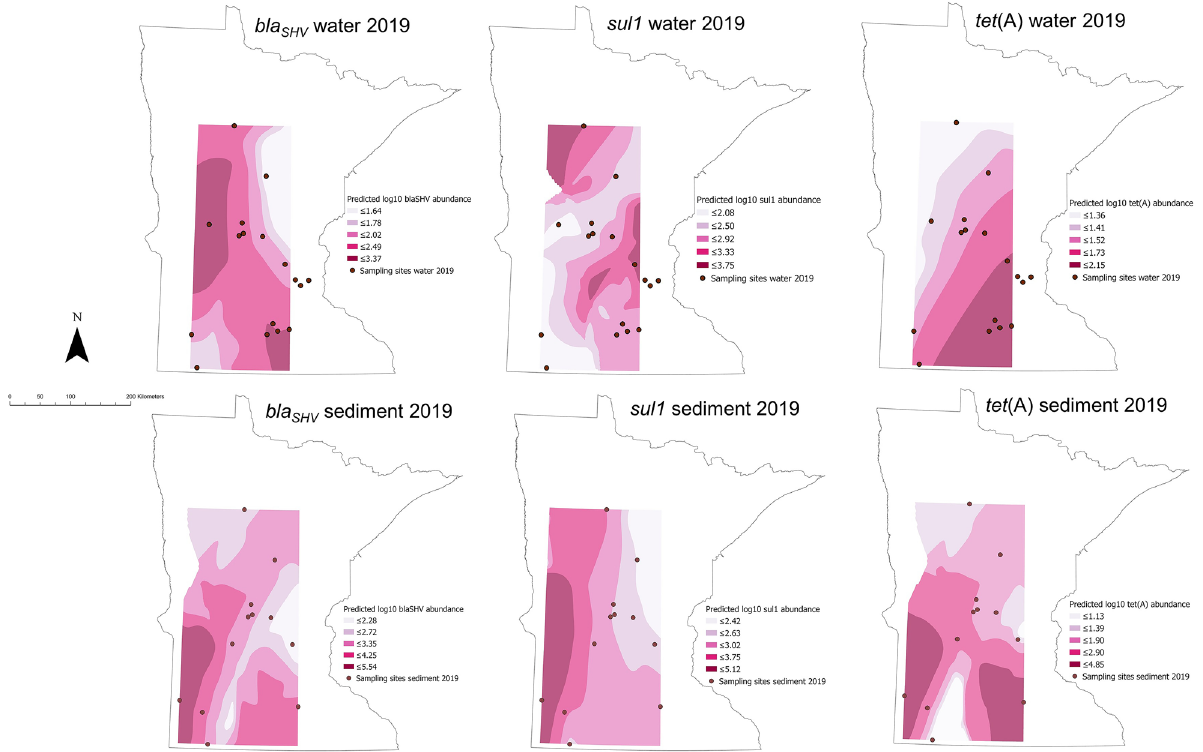
Figure 8. Contour maps resulting from the kernel interpolation for predicted antimicrobial resistance gene abundance in water and sediment samples in 2019